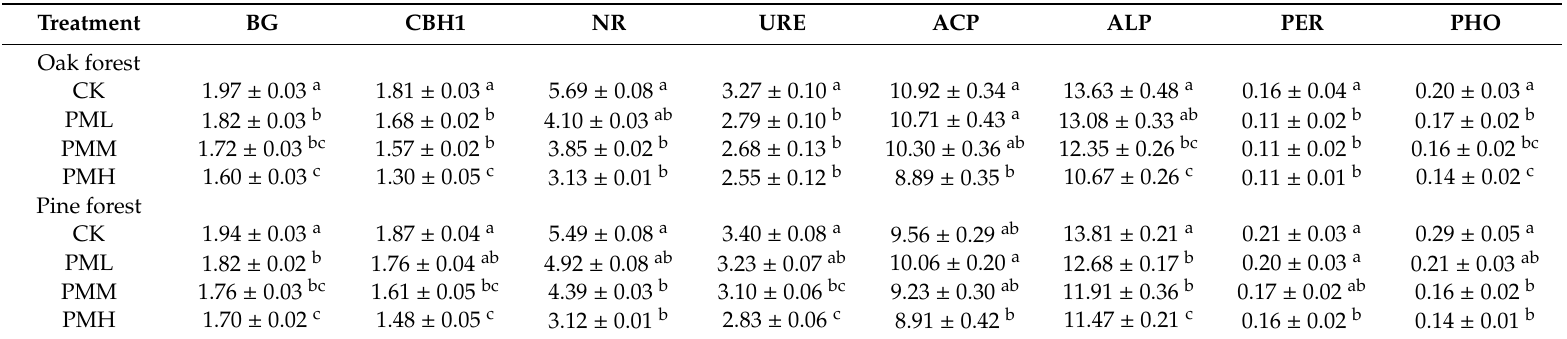
Table 5. E ff ects of WSII–PM 2.5 on extracellular enzyme activities during six months of decomposition in the two forests.